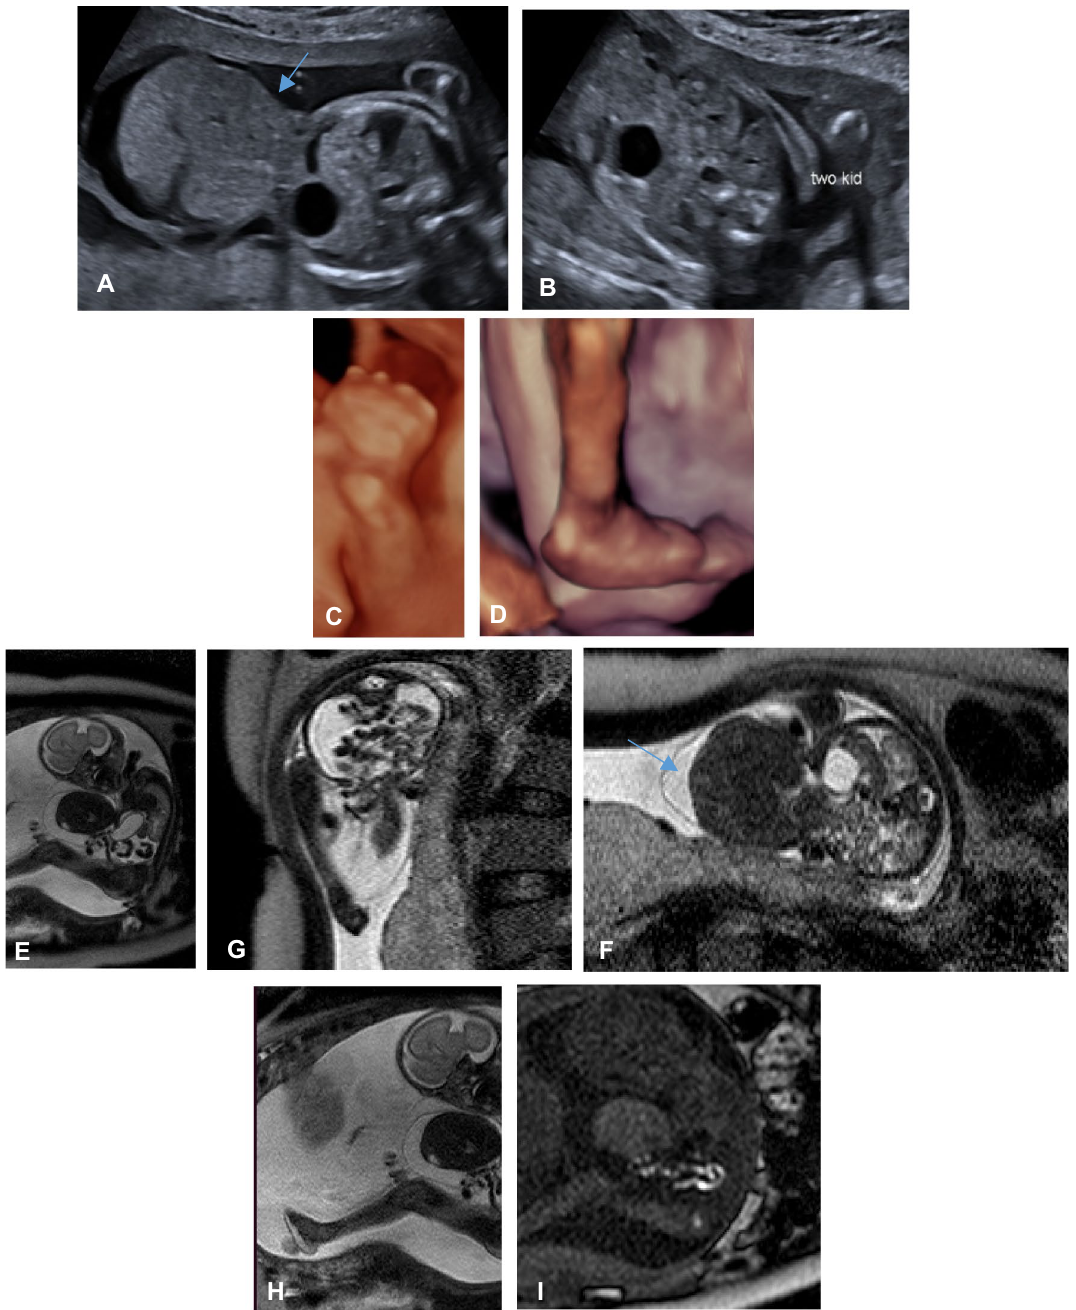
Fig. 3 A 26-year-old pregnant female with a routine 2nd trimester 4D US showing large ventral abdominal wall defect. Ultrasound findings ( A ), B axial sections of the fetal abdomen show a large central abdominal wall defect with herniation of the right hepatic lobe and bowel loops through. C , D sagittal 4D images revealing clenched hands and rocker bottom feet deformity. MRI findings: E , H sagittal T2WIs showing herniated liver and small bowel loops with an overlying thin membrane and associated rocker bottom feet. F , G axial T2WIs showing the size of the hernia defect, content as well as clenched hand. I sagittal T1WIs showing meconium signals within herniated bowel distal ileal loops. Diagnosis: The combination of skeletal anomalies with large Omphalocele suggested underlying chromosomal abnormality and trisomy 18 was diagnosed by postnatal chromosomal analysis. Termination by C.S. at 37